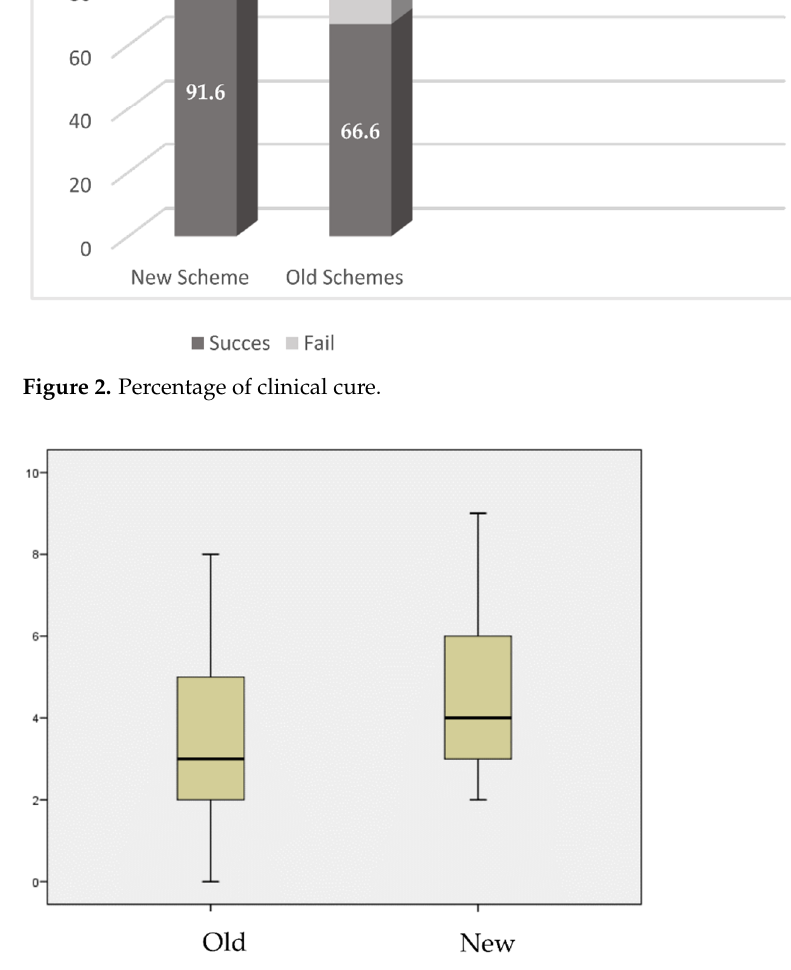
Figure 3. Charlson score according to each group.